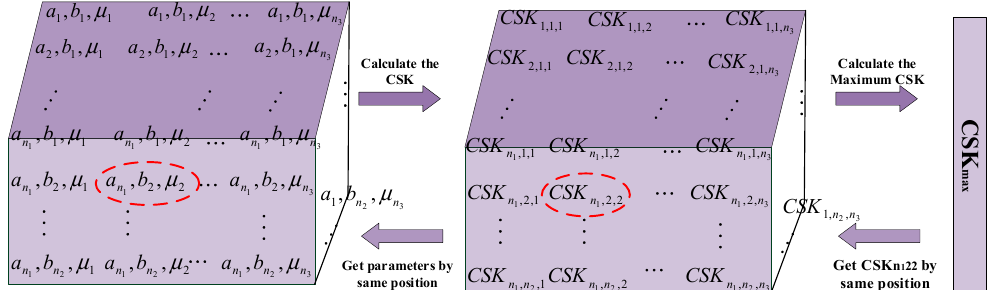
Figure 3. Flowchart of adaptive APHSR theory.